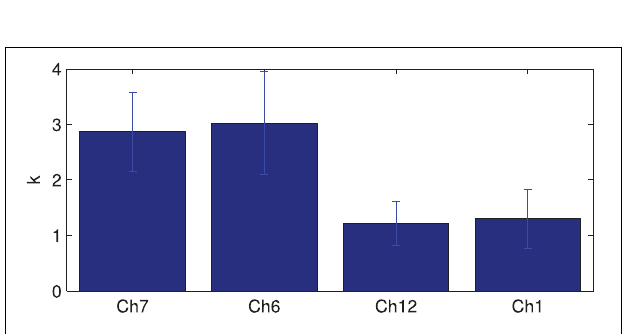
FIGURE 7 | ROI connections comparison between language area (represented by channels 7 and 6) and outside language area (represented by channels 1 and 12). The bars indicate the standard error of the mean.